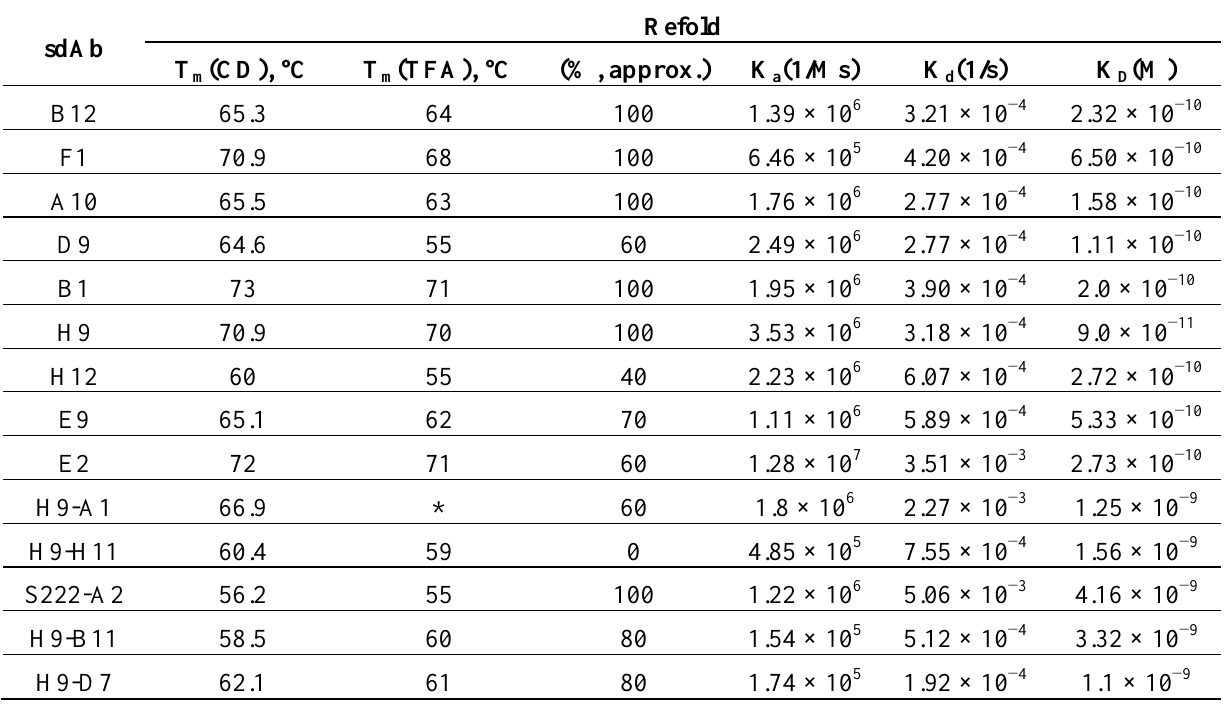
Table 1. Melting temperature determination, refolding ability, and binding kinetics for SEB-binding